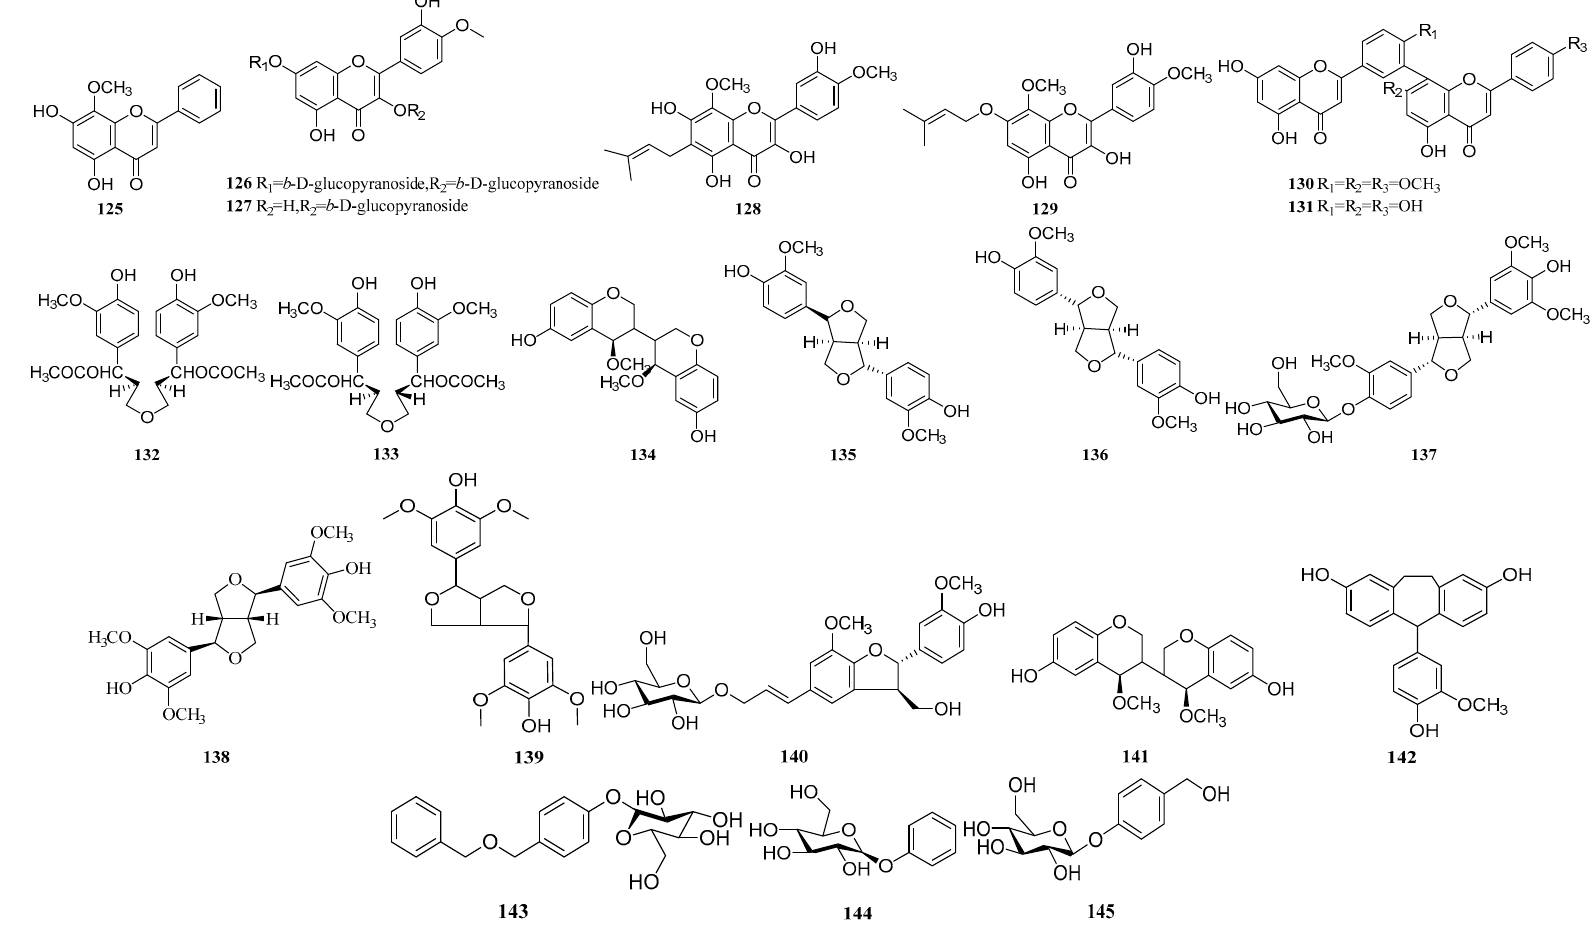
Figure 4. The structures of other compounds.